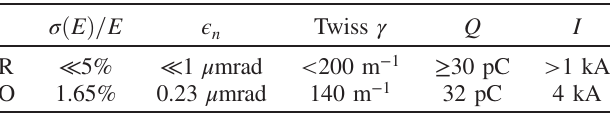
TABLE I. Requested beam quality ( “ R ” raw) and quality parameters obtained by means of the simulations reported in the paper ( “ O ” raw). The relative energy spread σ ð E Þ =E , normalized emittance ϵ , Twiss parameter γ , charge Q and peak n current I are